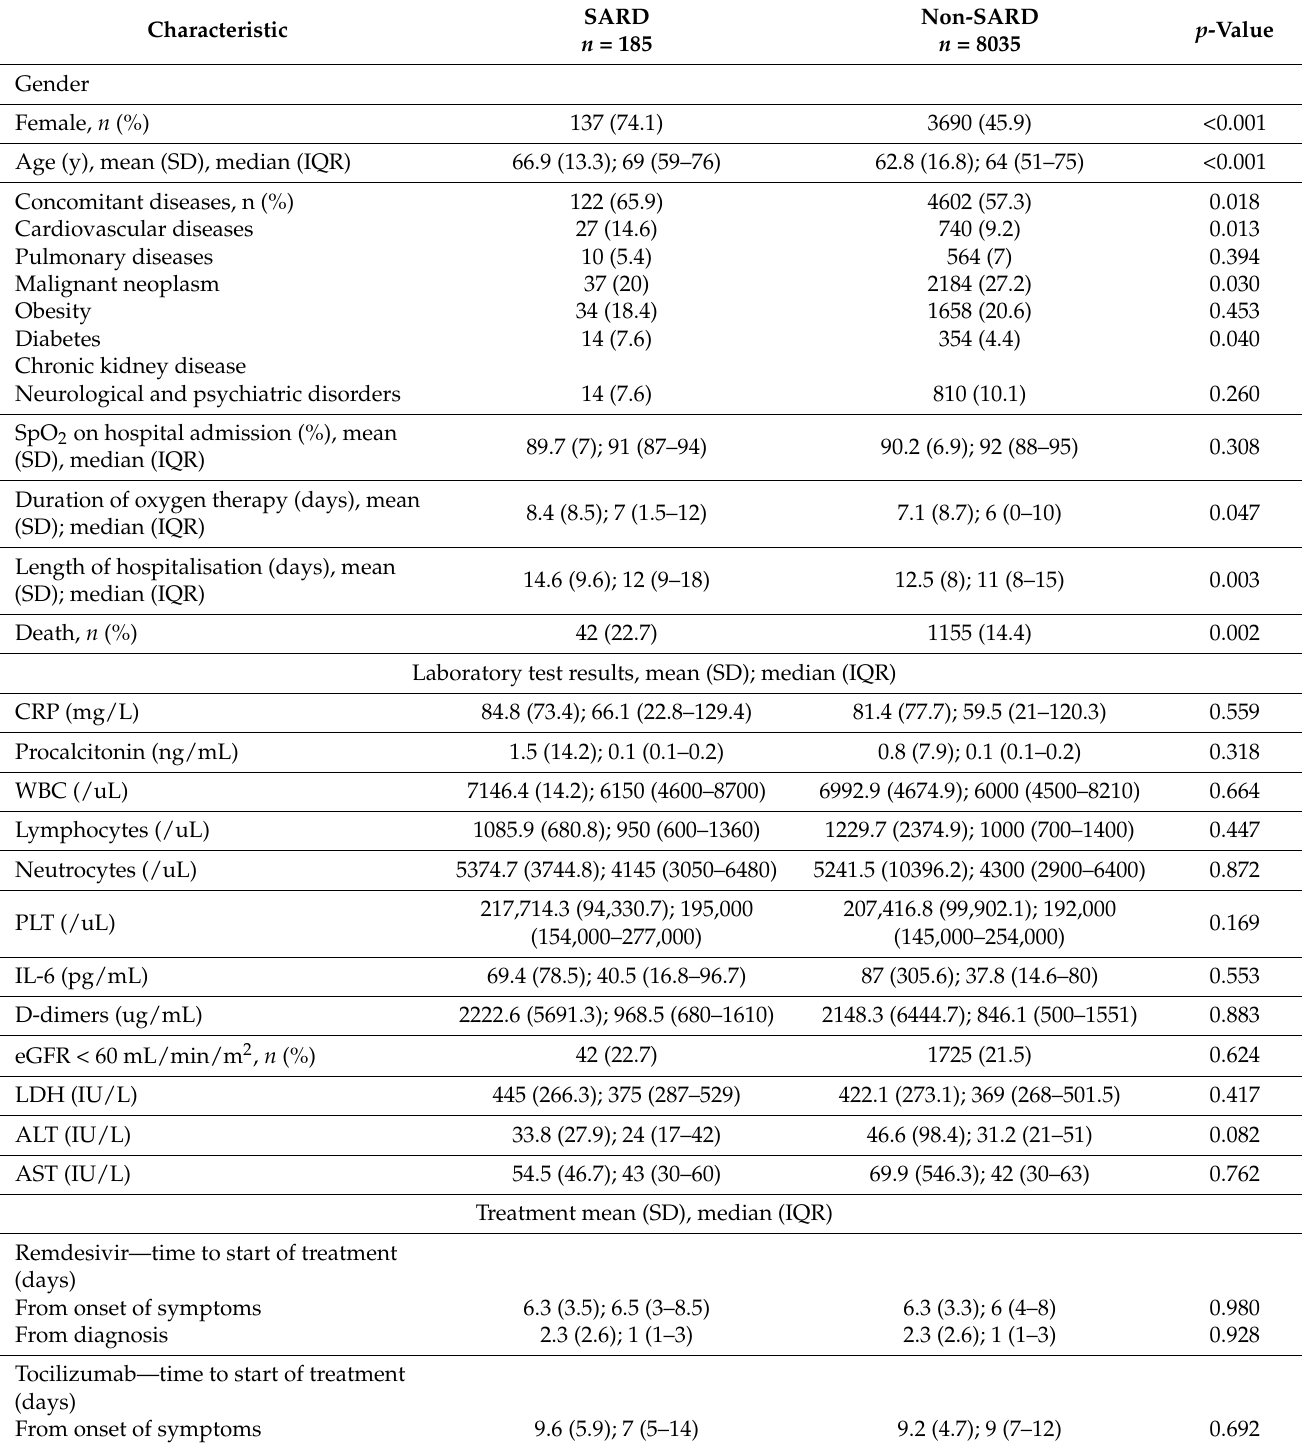
Table 3. Baseline clinical and laboratory characteristics in the groups with and without